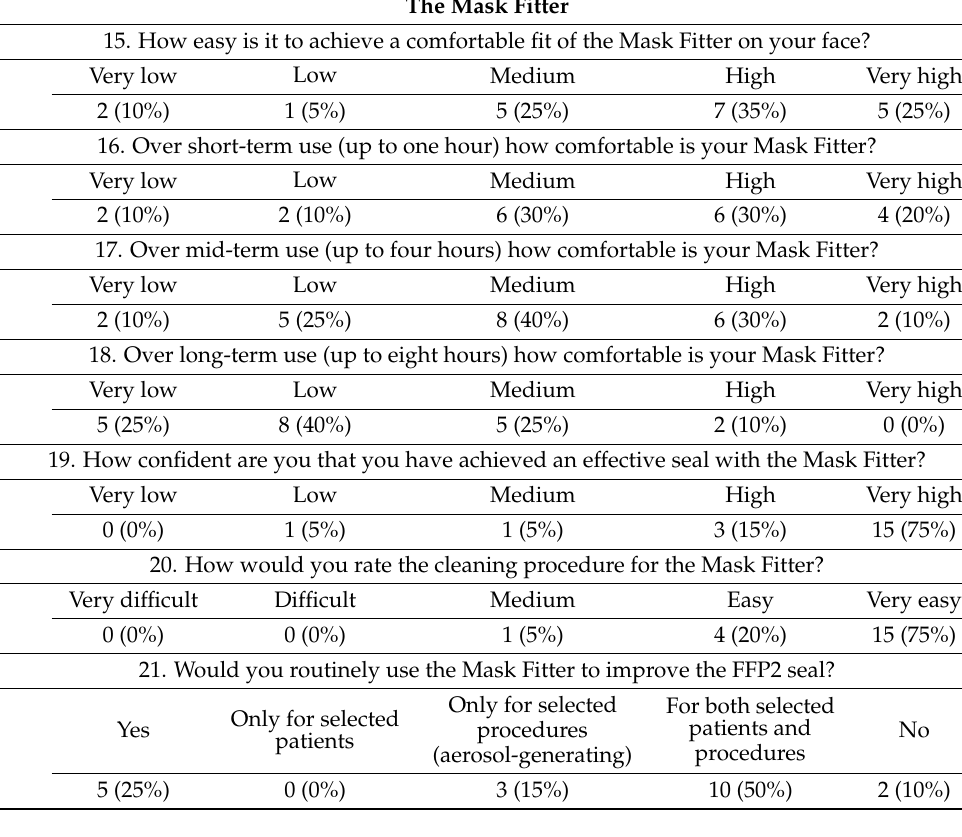
The Mask Fitter